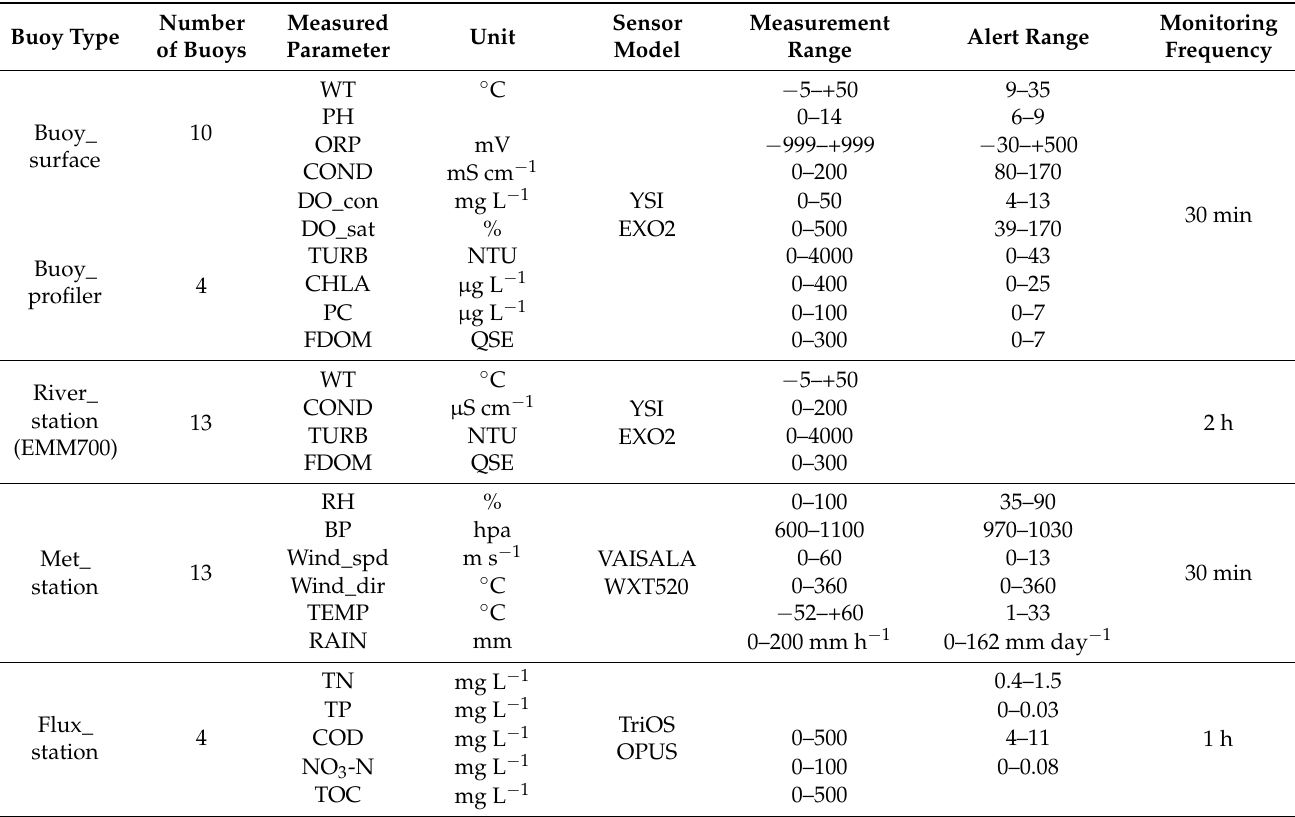
Table 1. Sensor metadata for all monitoring buoys at Lake